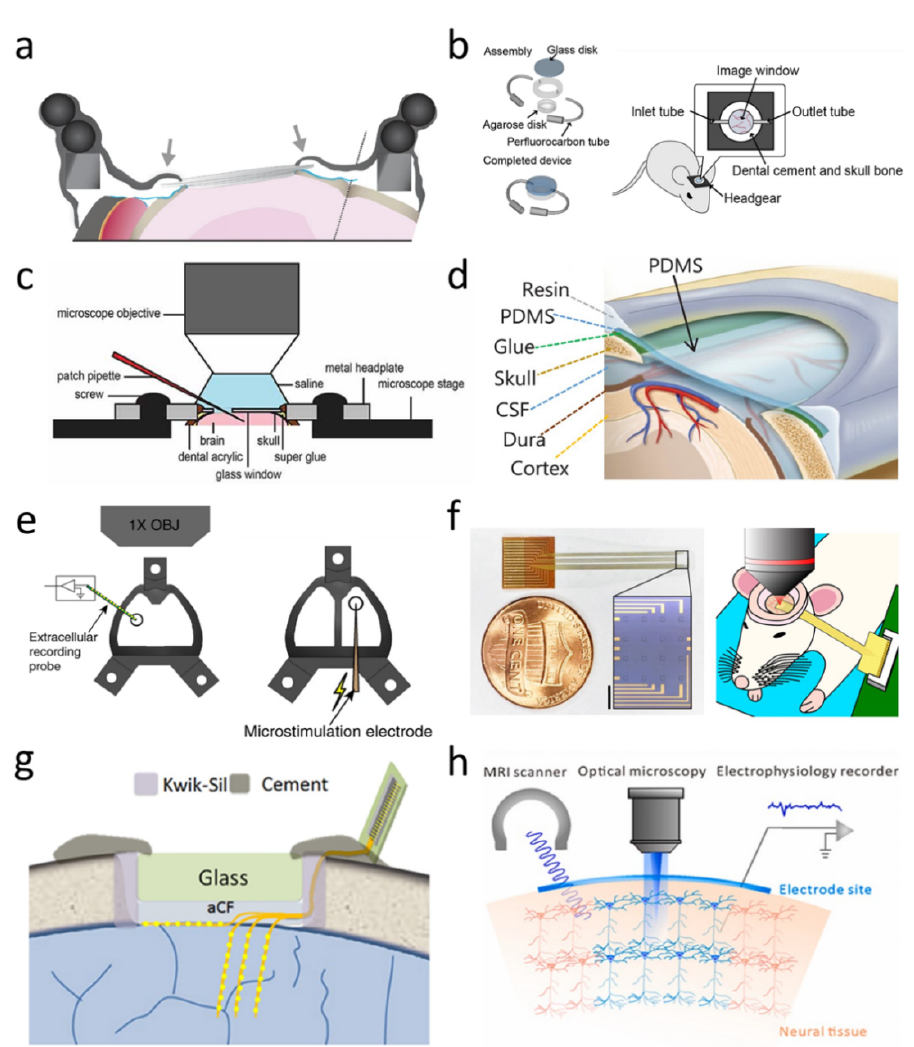
Figure 1. Eight kinds of typical multifunctional cranial windows in brain studies. ( a ) A cross-section view of a chronic cranial widow where the glass sheet could be replaced. Adapted with permission from [65]. 2014, Springer Nature. ( b ) “Lab-on-a-brain” on a mouse. Adapted with permission from [67]. 2014, Hiroaki Takehara et al. ( c ) A glass cranial window with a built-in silicone sealed hole for multiple injections. Adapted with permission from [64]. 2014, Christopher J. Roome and Bernd Kuhn. ( d ) A PDMS cranial window for rats and mice. Adapted with permission from [74]. 2016, Chaejeong Heo et al. ( e ) A “See-Shells” cranial window for combined electrical and optical experiments. Adapted with permission from [61]. 2019, Leila Ghanbari et al. ( f ) A transparent graphene sheet was applied as microelectrodes under a glass coverslip. Adapted with permission from [137]. 2018, Martin Thunemann et al. ( g ) Ultra-flexible nano-electronic threads was applied as microelectrodes under a glass cranial window. Adapted with permission from [50]. 2018, Elsevier. ( h ) A cranial window with “hydrogel-elastomer neural interface”. Adapted with permission from [62]. 2022,